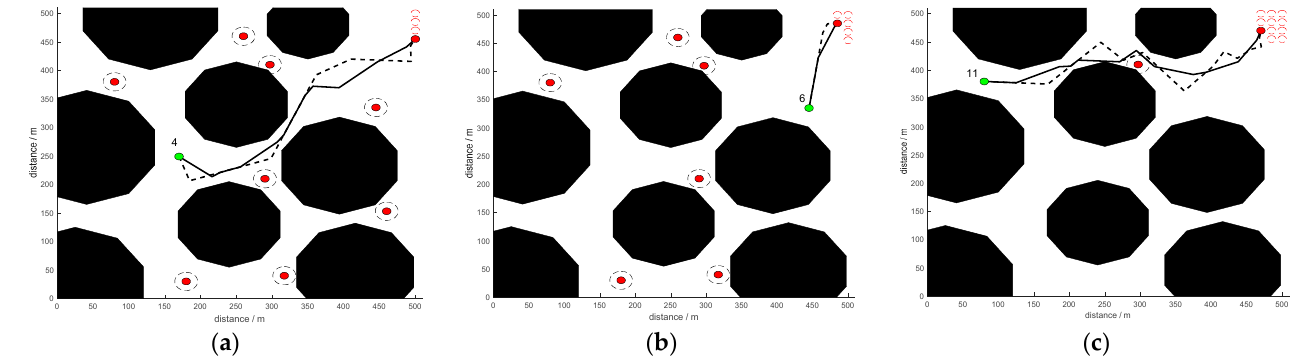
Figure 17. Optimization of different vehicle path results with dual RRT optimization under Map No. 2. ( a – c ) represent the optimization results for vehicle No. 4, vehicle No. 6, and vehicle No. 11, respectively.